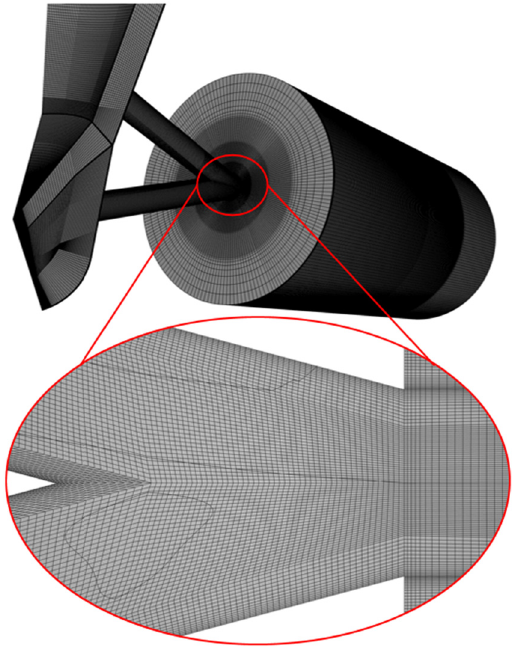
Figure 2: Detail of the meshes in the computational domain.